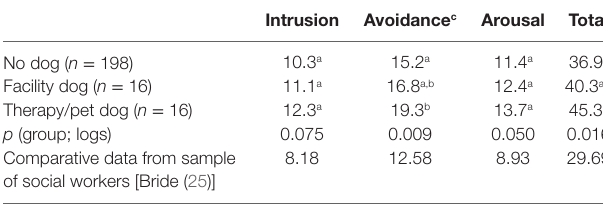
TaBle 1 | Secondary traumatic stress scale mean subscale